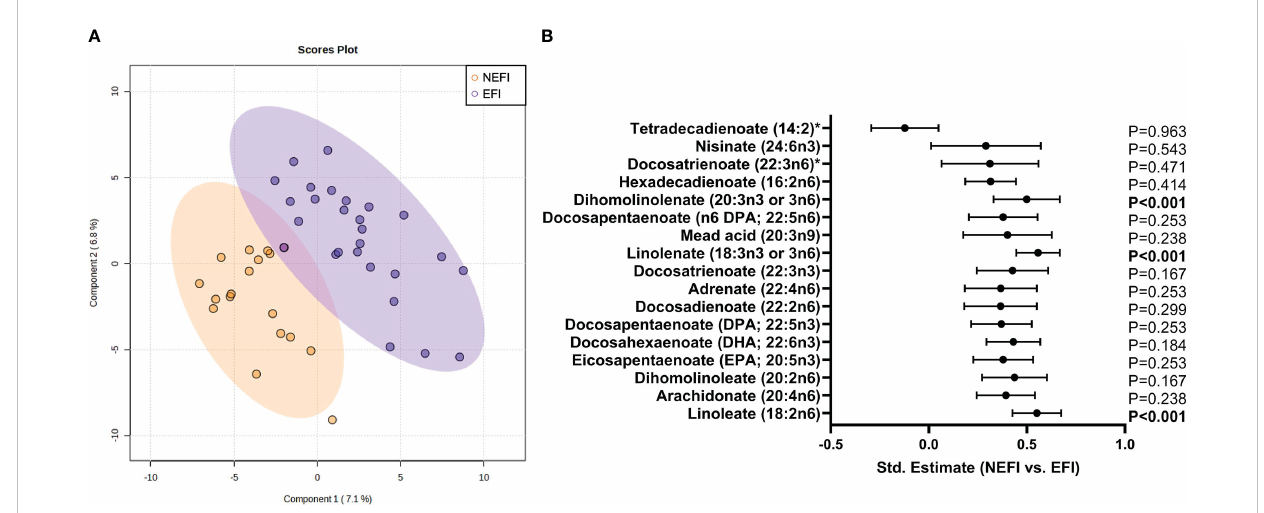
FIGURE 3 Endometrial metabolomic signature analysis in women with no detectable endometrial dysfunction in comparison to patient group with endometriosis and recurrent implantation failure. (A) Multivariate Partial Least Squares Discriminant Analysis scores plot from women with no detectable endometrial dysfunction and women with endometrial-factor infertility. (B) Statistical differences in long chain polyunsaturated fatty acid metabolism between women with no detectable endometrial dysfunction and women with endometrial-factor infertility. Statistical signi fi cance was set p -value<0.05 after FDR correction. NEFI, no endometrial-factor infertility; EFI, endometrial-factor infertility.